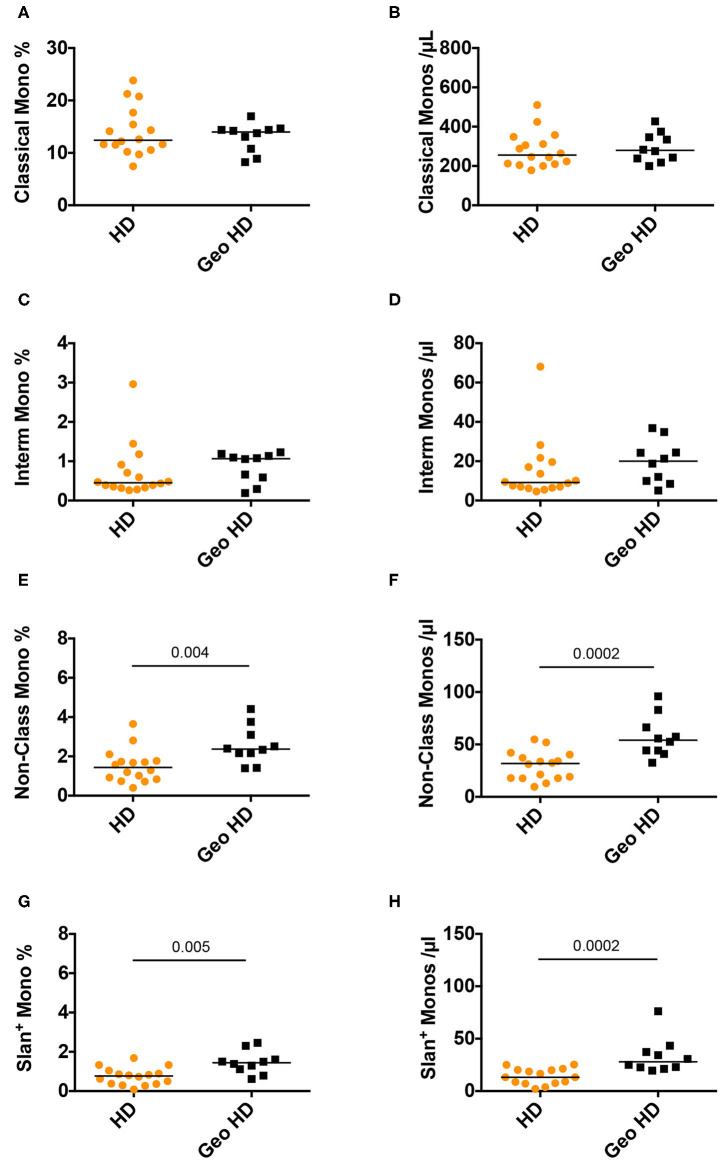
Monocyte subset percentages among CD45+ PBMC and absolute counts in controls from the blood bank (HD) compared to controls of West-African origin (GeoHD). (A) Classical monocyte (CD14++CD16−) percentages among CD45+ PBMC and (B) absolute counts/μL blood, (C) intermediate monocyte CD14+CD16+ percentages and (D) absolute counts / μL blood, (E) non-classical monocyte (CD14±CD16+) percentages and (F) absolute counts, (G) slan+ monocyte percentages and (H) absolute counts, in the two groups of age- and sex- matched healthy donors residing in the Paris area, one from the French Blood Bank (EFS) (HD) and the other of West-African origin (GeoHD). Orange: unknown origin, Black: West-African origin. Horizontal bars represent median values. Mann-Whitney's post-test p are represented above the horizontal line connecting the compared groups. Kruskall-Wallis tests and descriptive statistics can be found in Table 2 (in italics for West-African participants).